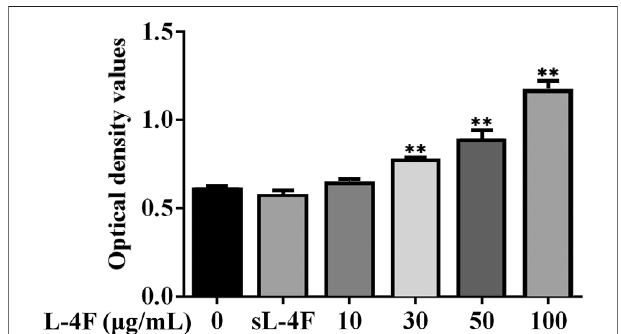
FIGURE3| L-4FimprovescellviabilityofHUVECs.Cellsweretreatedfor 24 h with L-4F at various concentrations ( fi nal concentrations at 0, 10, 30, 50, and 100 μ g/ml, respectively) or sL-4F at 50 μ g/ml, n (cid:1) 6, one-way ANOVA, SNK test, ** p < 0.01, compared with the group at 0 μ g/ml.